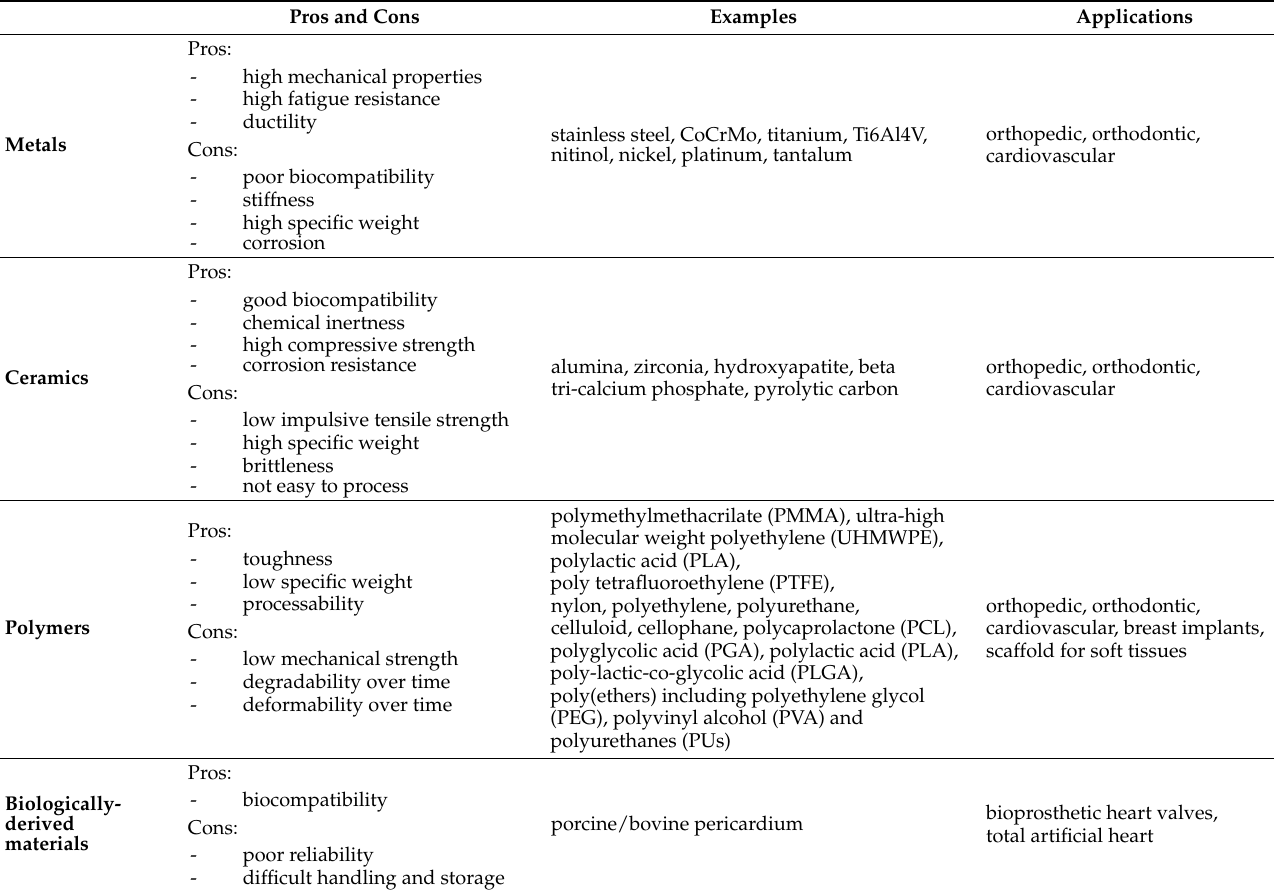
Figure 1. The history of biomaterials: from replacement to regeneration. Table 1. Classes of biomaterials and their most relevant clinical